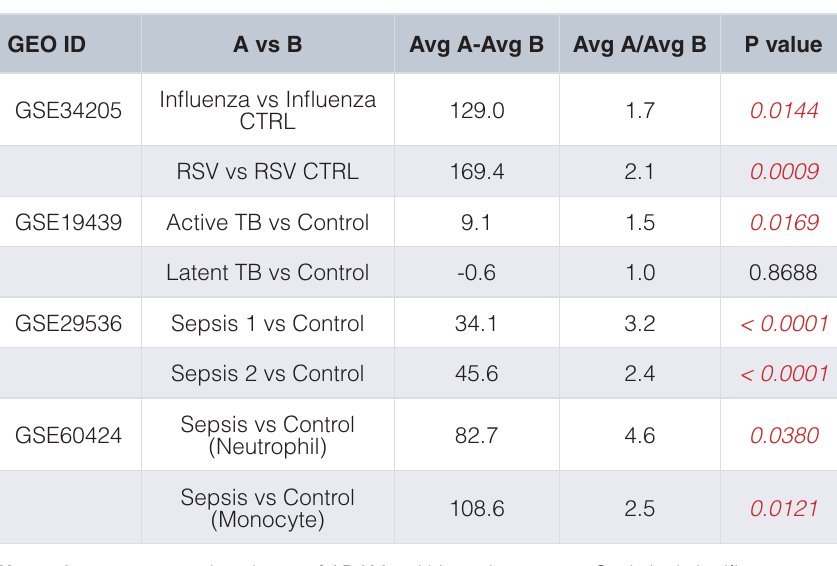
Table 1. Increased abundance of ADAM9 during